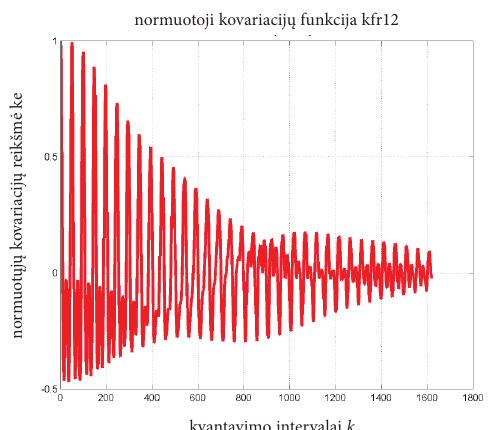
5 pav . Normalių moteriškųjų ląstelių abiejų 21-ųjų chromosomų tarpusavio normuotoji kovariacijų funkcija Fig. 5 . Interrelation normalised covariance function of both normal female chromosomes 21 in cells